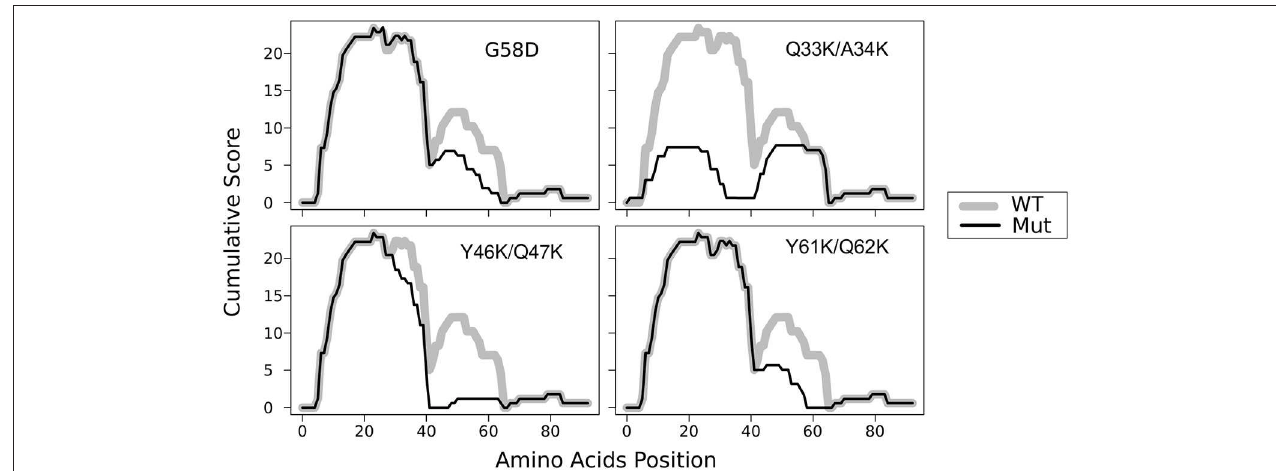
FIGURE 1 | Substitutions Q33K/A34K within N-domain of Sup35 decrease the amyloidogenic potential of the protein. The ArchCandy program (Ahmed et al., 2015) was used to predict amyloidogenic properties. Cumulative scores (sum of β -arch scores counted for each amino acid residue) are presented on the plot. WT — wild-type protein; G58D, Q33K/A34K, Y46K/Q47K, and Q61K/Q62K substitutions that correspond to mutations PNM2 , sup35-M0 , -M1 , and -M2 , respectively.